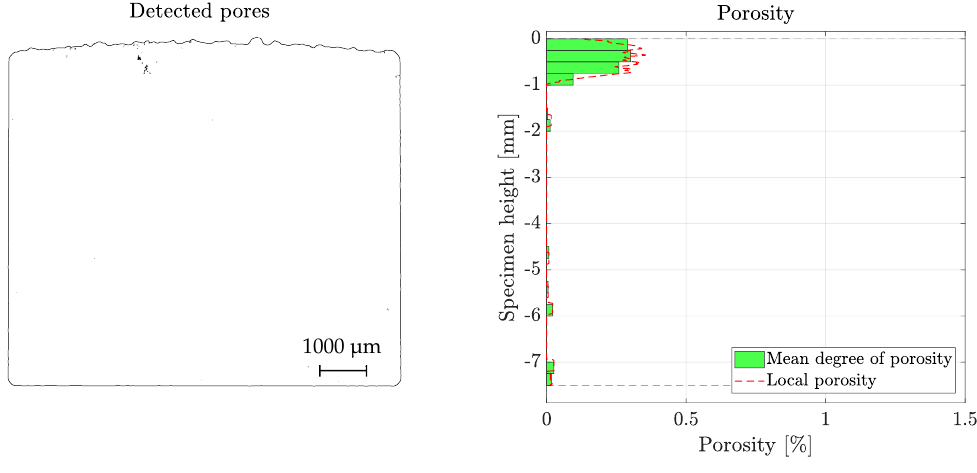
Figure 7. Detected pores and degree of porosity of an exemplarily cast surface HIP P1 cross